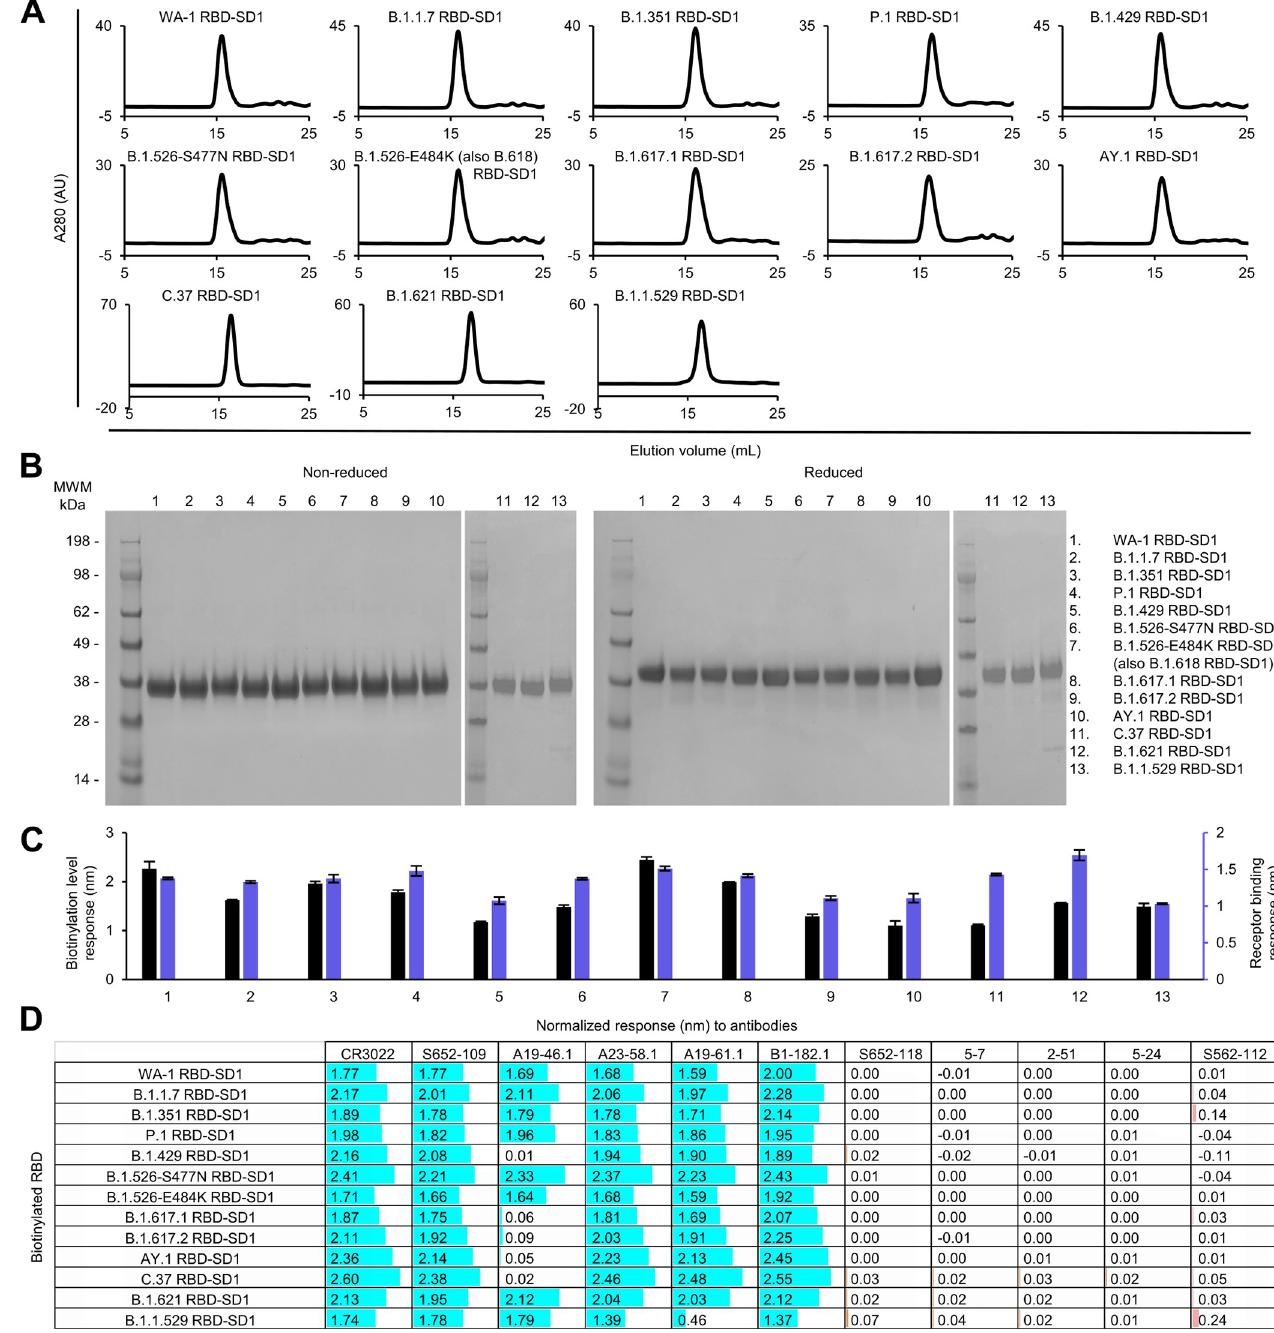
Fig 7. Characterization of biotinylated SARS-CoV-2 variant RBD-SD1 confirms their homogeneity and antibody-binding specificity. (A) Size exclusion chromatography of the purified biotinylated SARS-CoV-2 RBD-SD1 probes, including original WA-1 RBD-SD1 and 12 other variant RBD-SD1 in PBS buffer. (B) SDS-PAGE of SARS-CoV-2 RBD-SD1 variant probes with and without reducing agent. Molecular weight marker (MWM) and the WA-1 RBD-SD1 probe were run alongside the variant RBD-SD1 probes. (C) Biotinylation and receptor recognition of the SARS-CoV-2 variant RBD-SD1 probes. The level of biotinylation was evaluated by capture of the RBD-SD1 probes at 5 μ g/ml onto the streptavidin biosensors using Octet. Receptor binding was assessed with 500 nM of dimeric ACE2. Error bars represent standard deviation of triplicate measurements. (D) Antigenicity assessment of the SARS-CoV-2 variant RBD-SD1 probes. Responses to RBD-directed, NTD-directed, and S2 subunit-directed antibodies were shown in cyan, orange, and rose, respectively. Bar scale between 0 and 3. Negative values not depicted. Variants with the L452R mutation lost binding to A19-46.1.